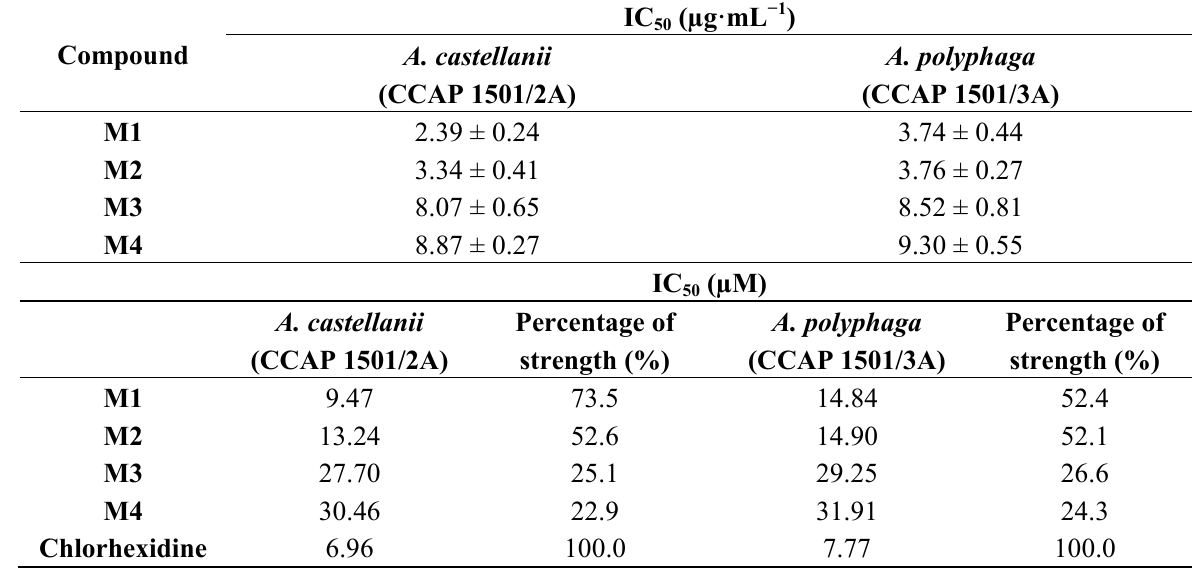
Table 2. The IC values of the newly-synthesized thiourea derivatives against Acanthamoeba 50 and their comparative strength (%) as compared with the positive control,